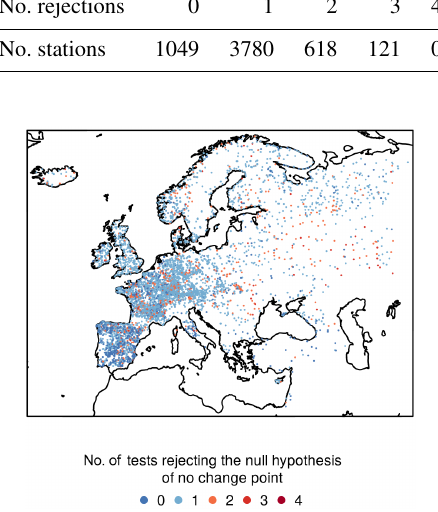
Figure 4. Homogeneity testing: number of tests that reject the null hypothesis of no breakpoint at each station considered at the 1% level. Stations marked blue (zero or one rejection) are considered useful . Stations marked red (more rejections) are considered sus- pect